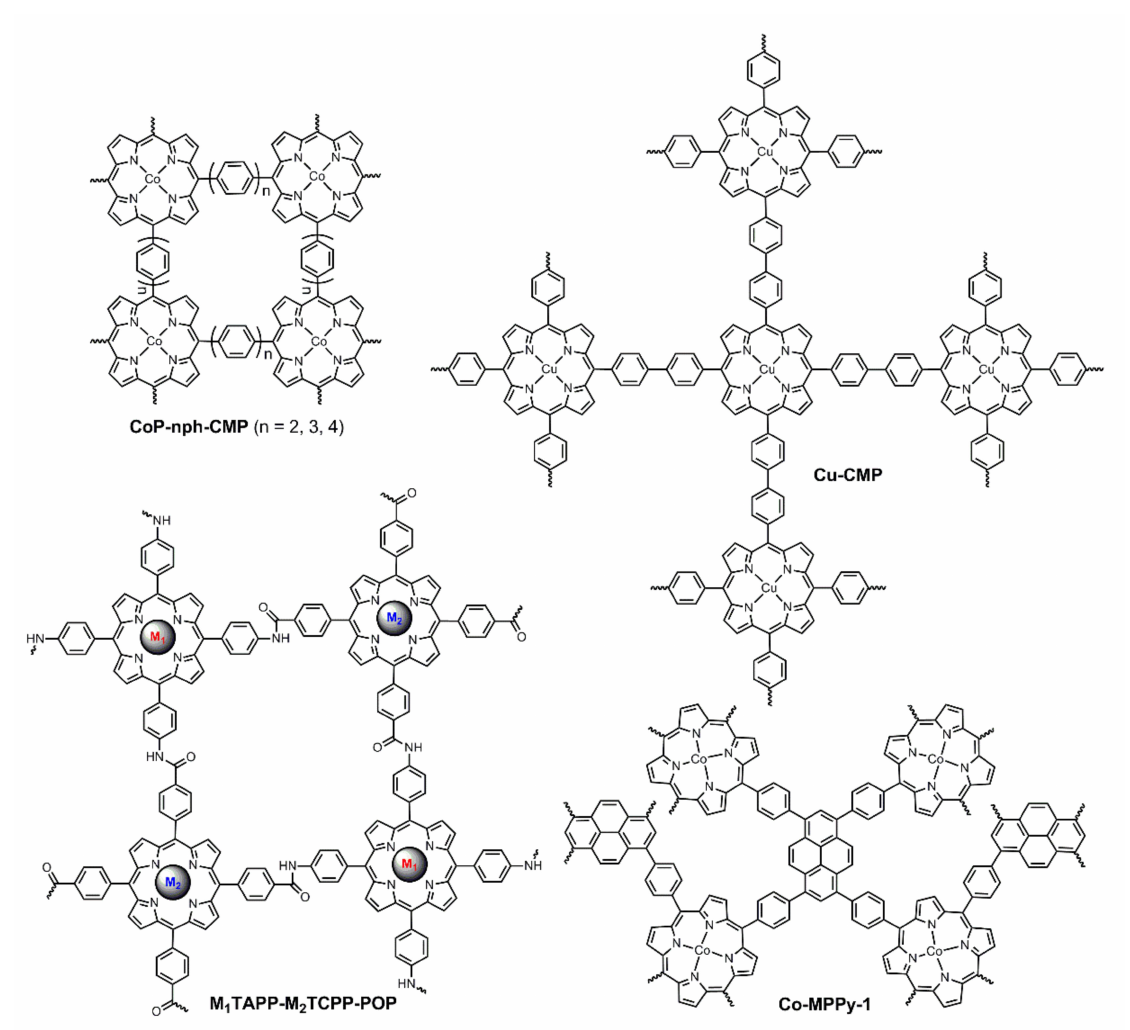
Figure 11. Porphyrin-based amorphous porous organic polymers for heterogeneously electrochemical OER. Reproduced from ref.